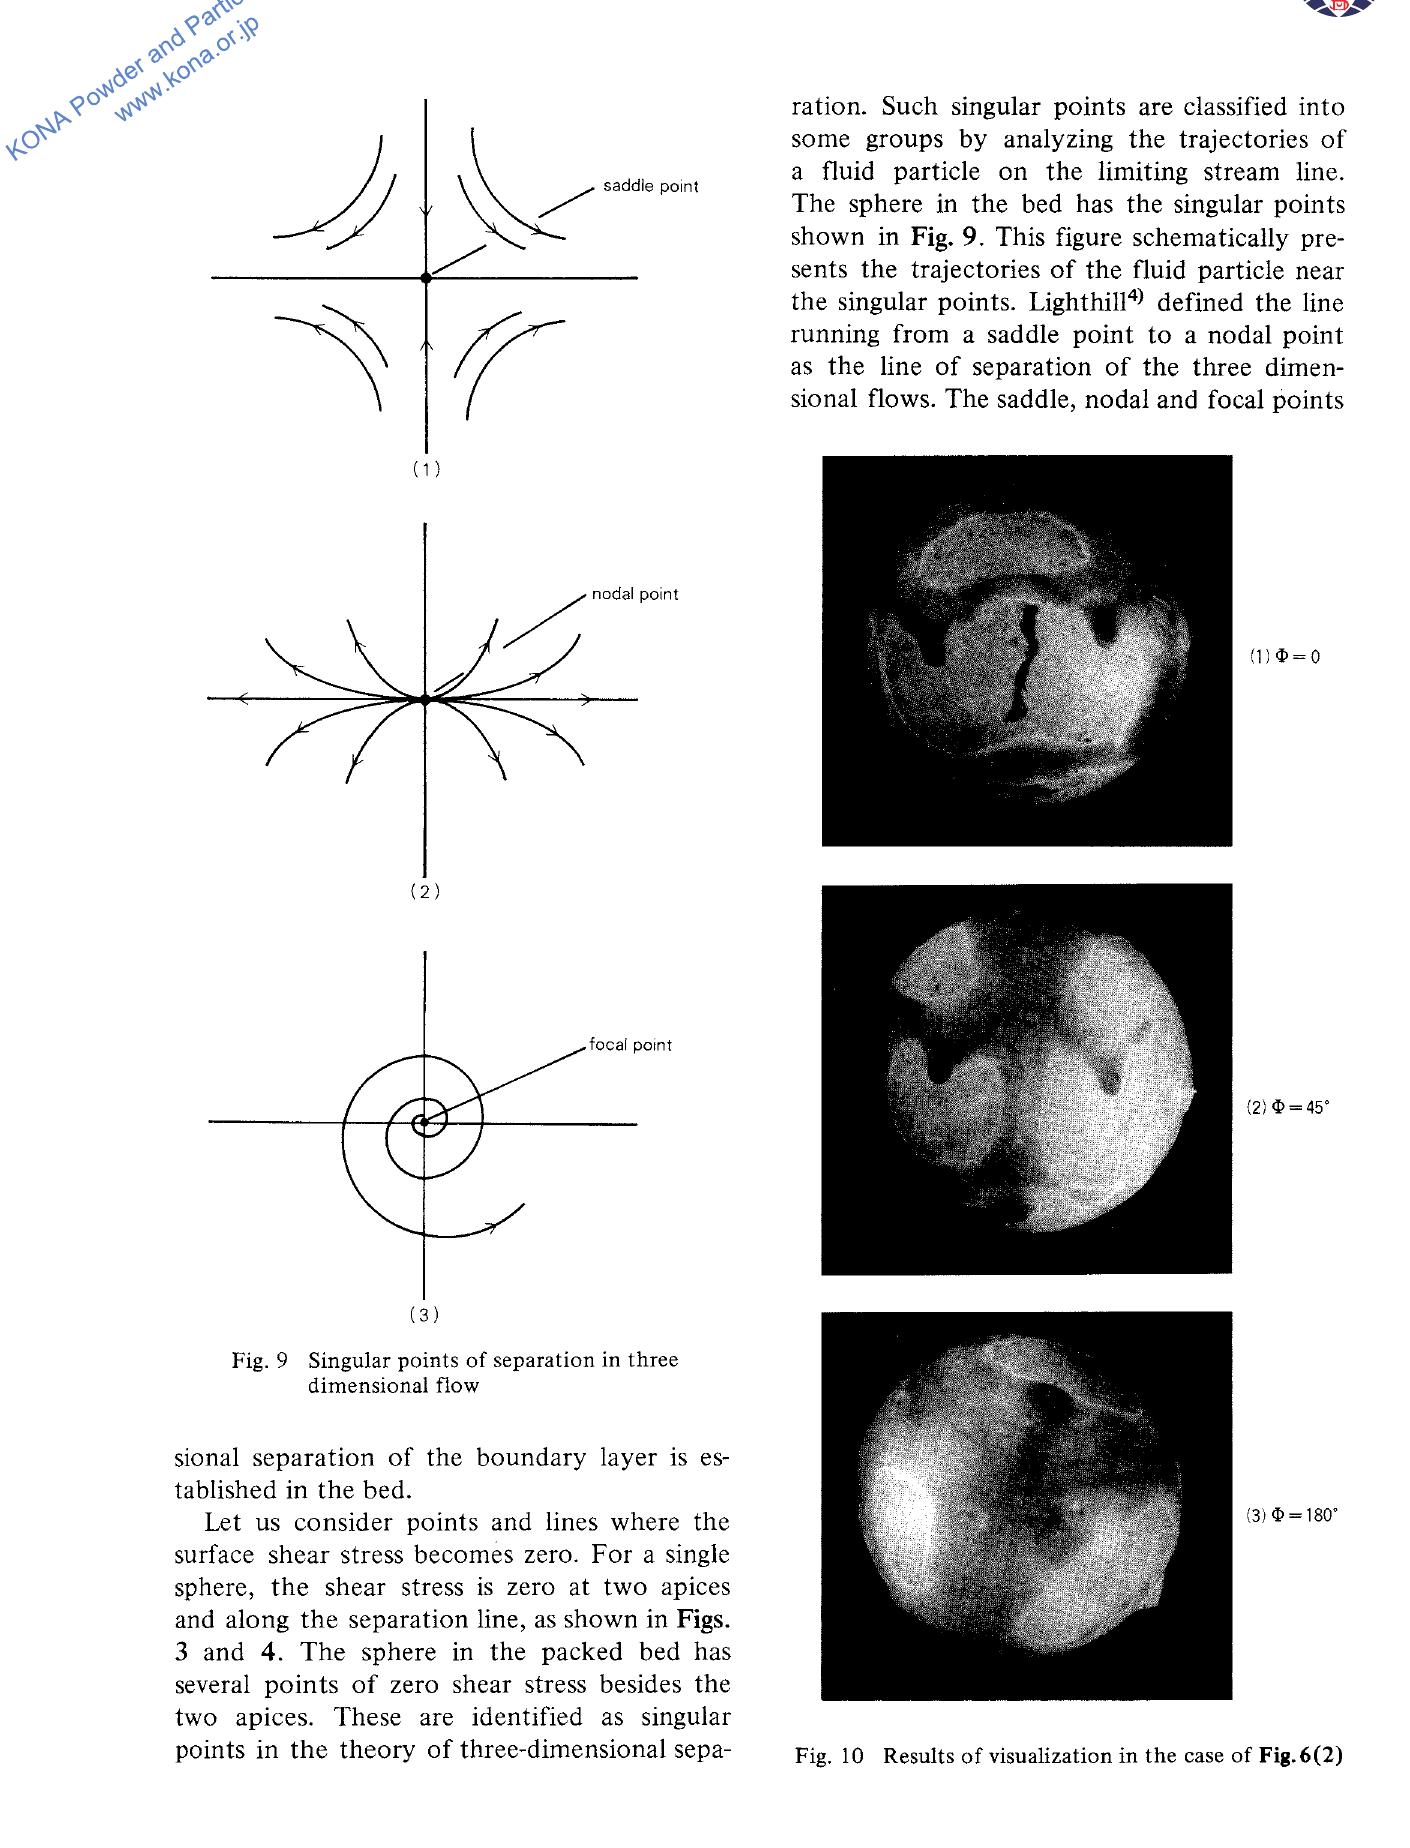
Fig. 10 Results of visualization in the case of Fig. 6(2)